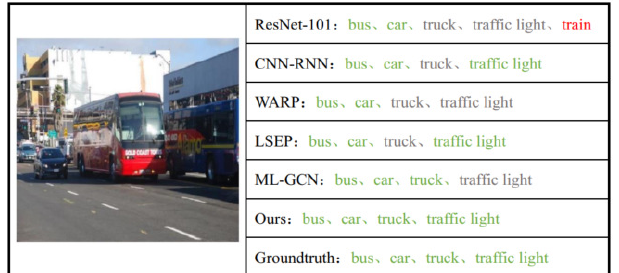
Figure 14. Qualitative results. Example 1.